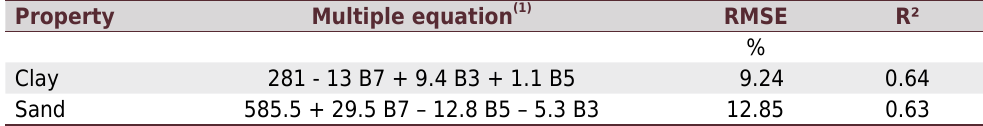
Table 3. Results obtained in validation of multiple linear regression elaborated from the soil reflectance of area 1 obtained at orbital